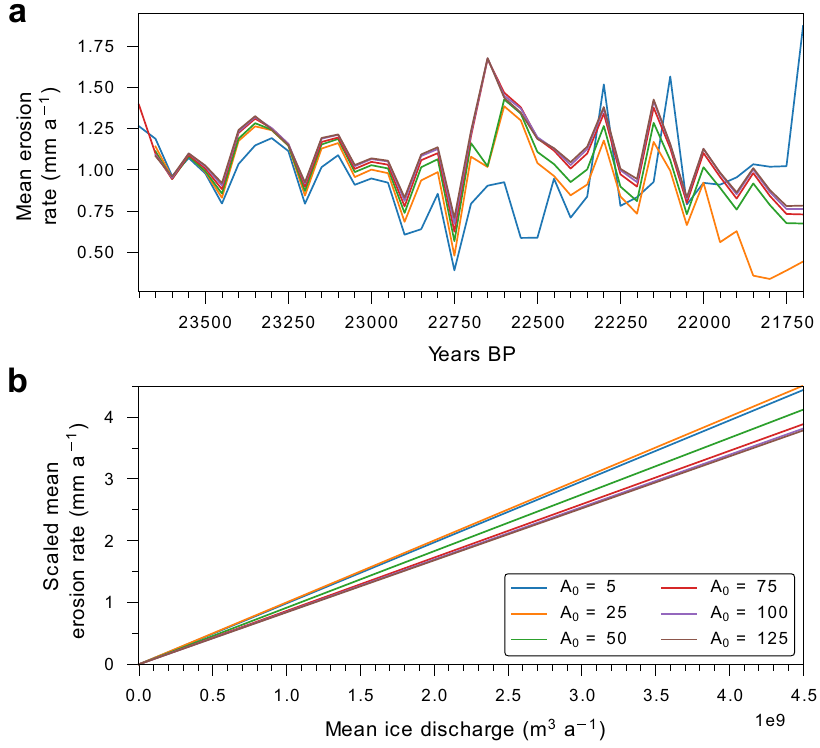
Fig.4|Potentialvariationinmodellederosionrates.a Meanerosionratesacross themid-Norwegianmargincatchment(Fig.2a)duringa2000-yearwindowaround the Last Glacial Maximum, through perturbations of the A 0 deformation enhancementfactorintheicemodel.Thevalueusedinouroptimumexperimentis